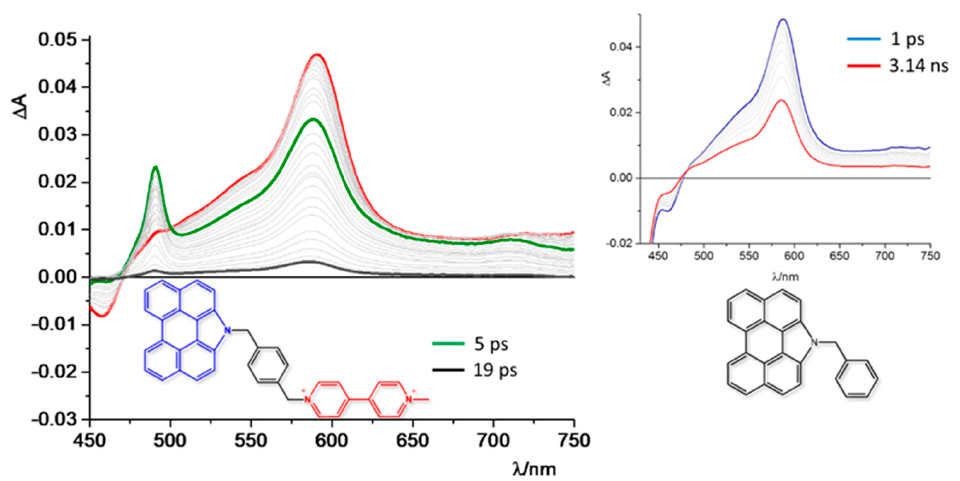
Figure 5. ( left ) Transient absorption spectra of NAP-B-V 2+ dyad in acetonitrile; red spectrum was registered immediately after the pump, and time delays for the green and black spectra are given in the panel. ( right ) Transient absorption spectra of NAP-B registered at different delays, indicated in